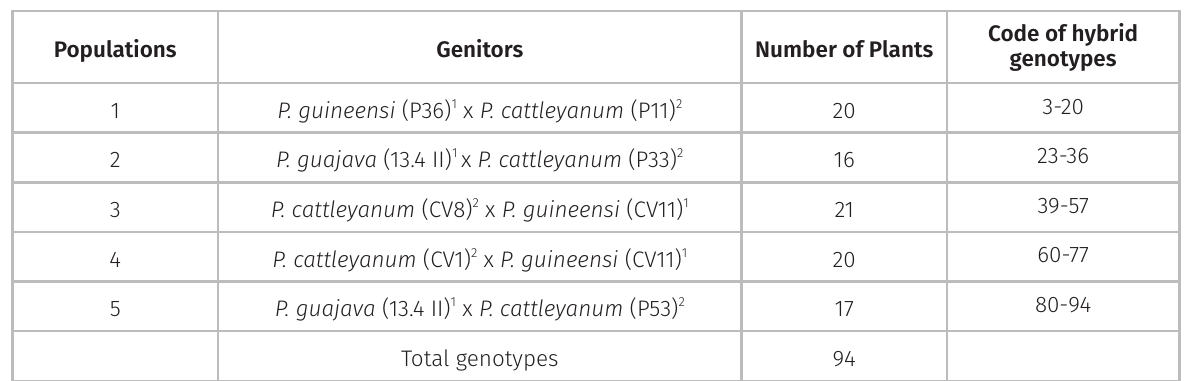
Table I. P. guineense, P. cattleyanum , and P. guajava genotypes used in the interspecific crosses to obtain segregating populations of Psidium spp. and number of resistant hybrid plants evaluated in each population with the